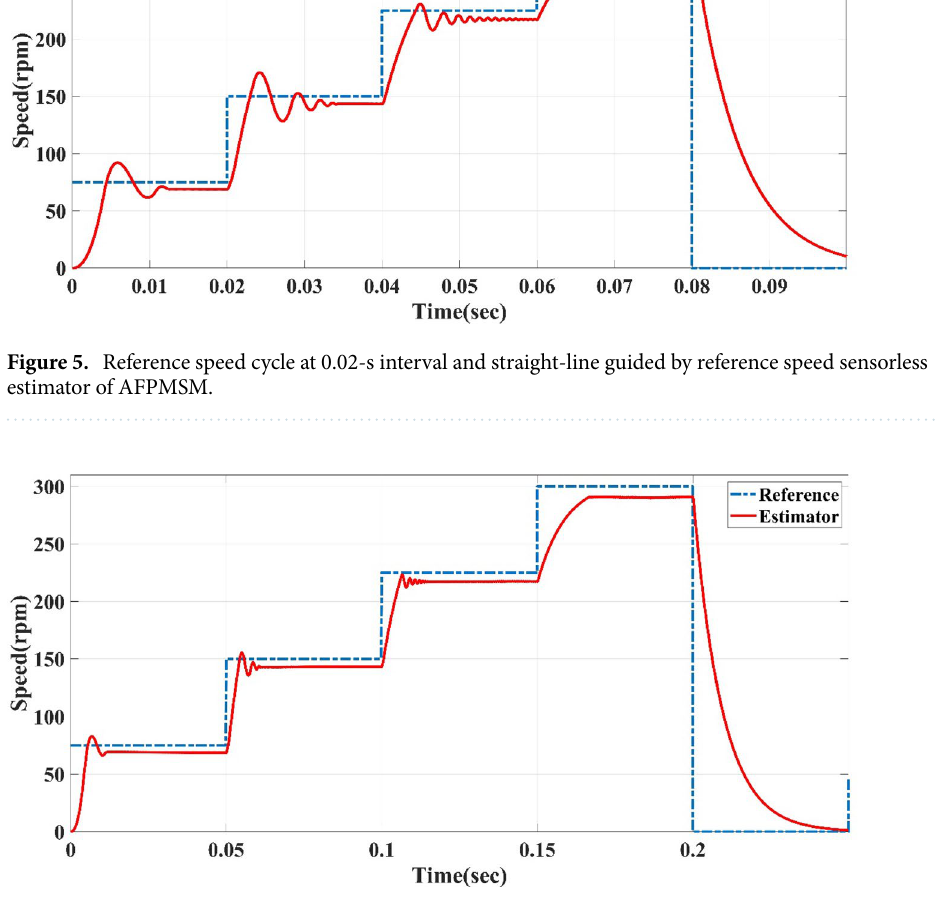
Figure 6. Reference speed cycle at 0.05-s interval and straight-line guided by reference speed sensorless estimator of